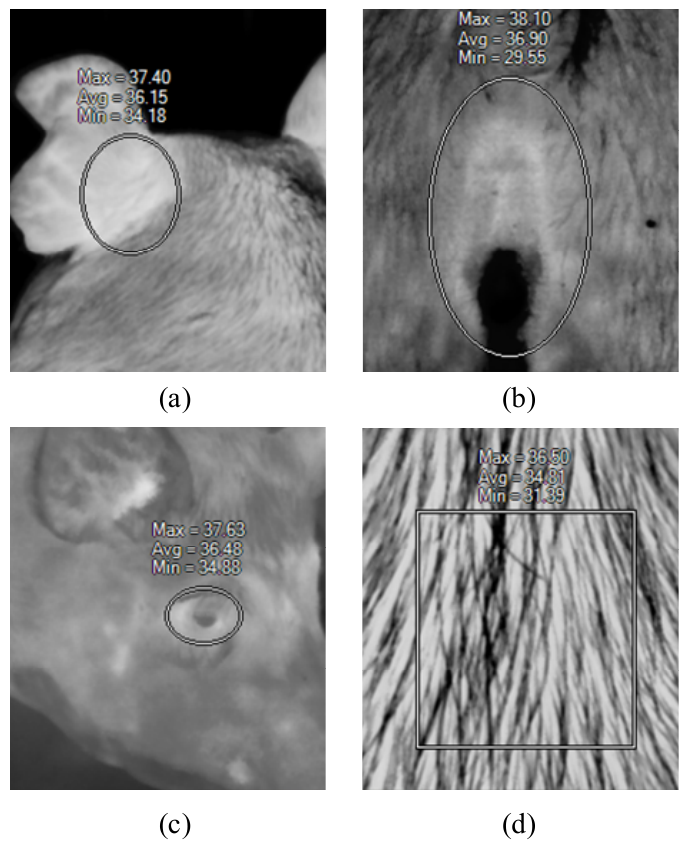
Figure 1. Region of interest (ROI) region definition in infrared image, ( a ) ear root ROI, ( b ) vulva ROI, ( c ) eyes ROI, ( d ) backside ROI. Note: the thermal images are displayed in a grayscale fashion.